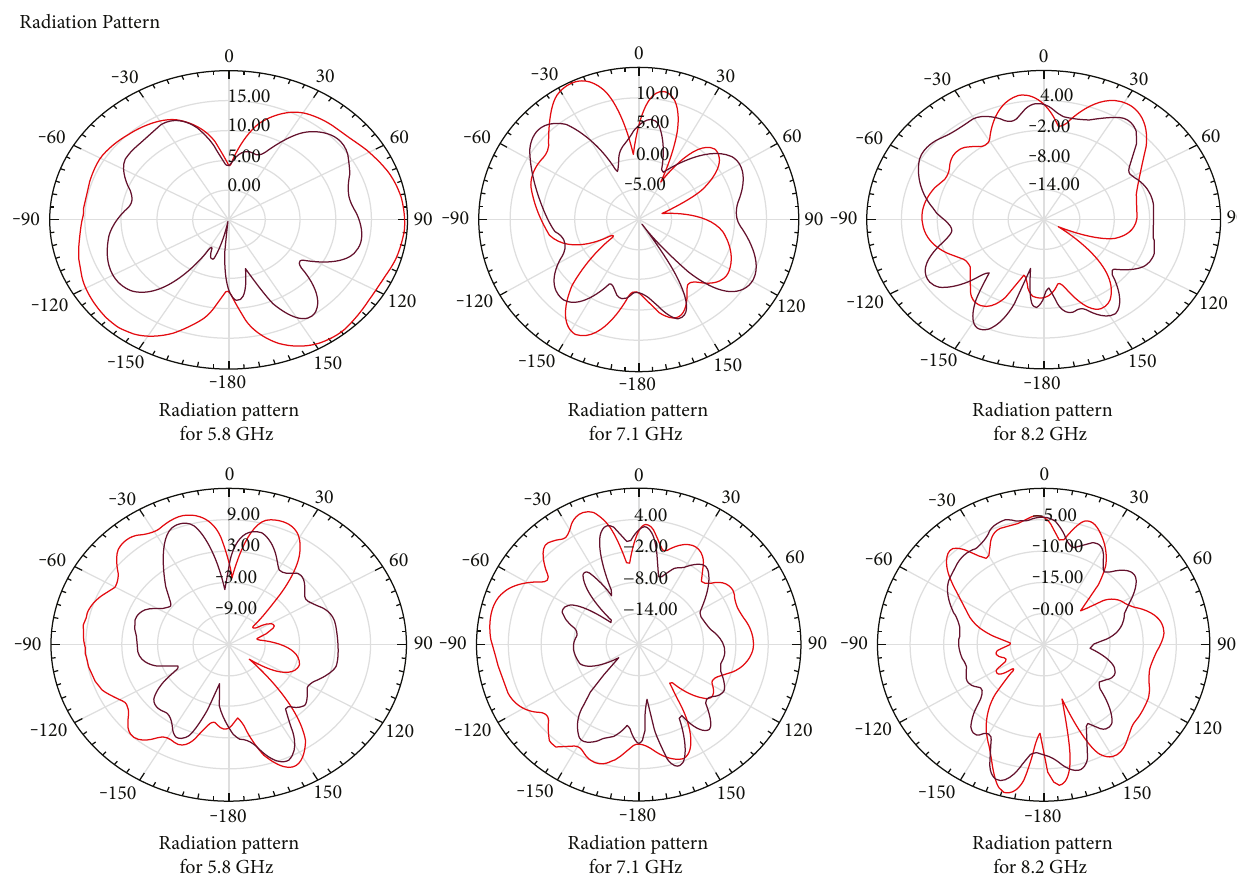
Figure 6: Radiation pattern of antenna at phi =0 degree and phi=90